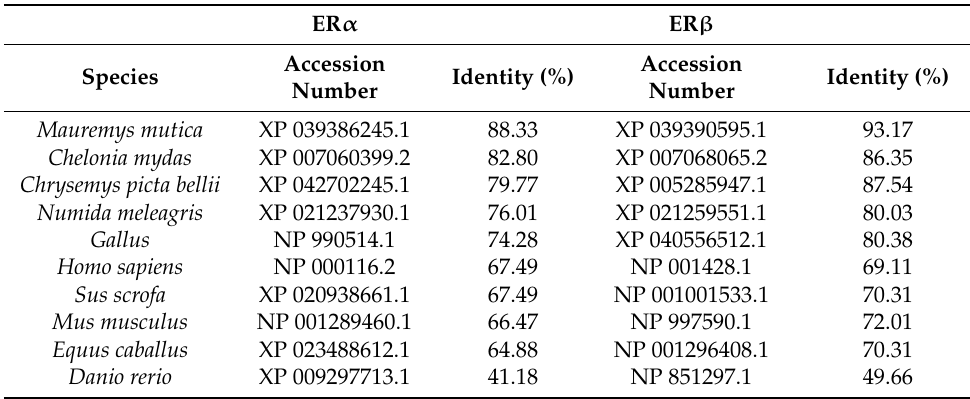
Table 2. Comparative identity of the amino acid sequence of